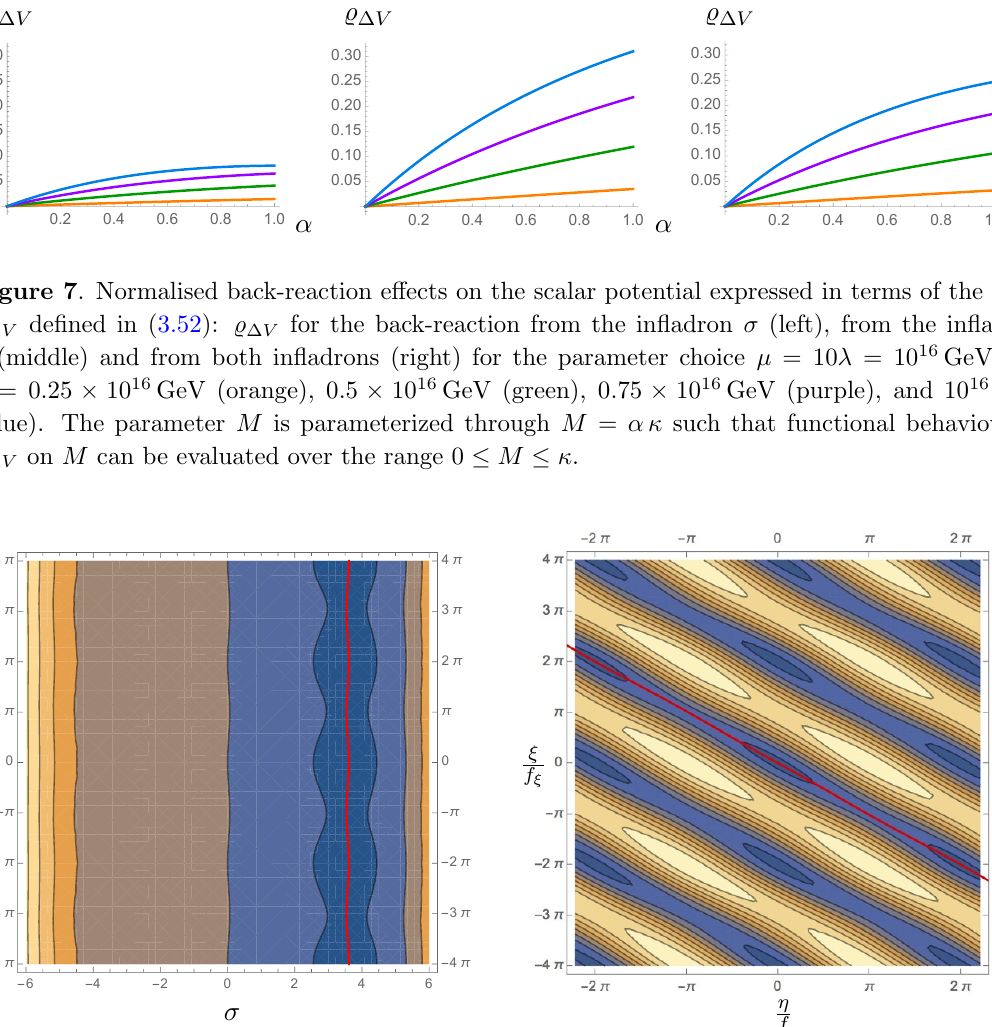
to the original scalar potential. Given the aforementioned constraints on the parameters ( M; (cid:20) ) the fraction of the back-reaction will be much lower and can even be kept below or about the percent-level. To explore potential (cid:13)at directions in the back-reacted scalar potential one can consider contour plots of the latter as a function of the various scalar (cid:12)elds, such as in (cid:12)gure 8. In these plots, the red curve identi(cid:12)es su(cid:14)ciently (cid:13)at directions, which can support trans-Planckian (cid:12)eld excursions of the in(cid:13)aton (cid:24) . Note that it su(cid:14)ces for the in(cid:13)aton (cid:24) to run over a distance (cid:1) (cid:24) = (cid:25)f starting from a local maximum to a local (cid:24) minimum along the indicated red curve, in order for in(cid:13)ation to take place with a proper amount of